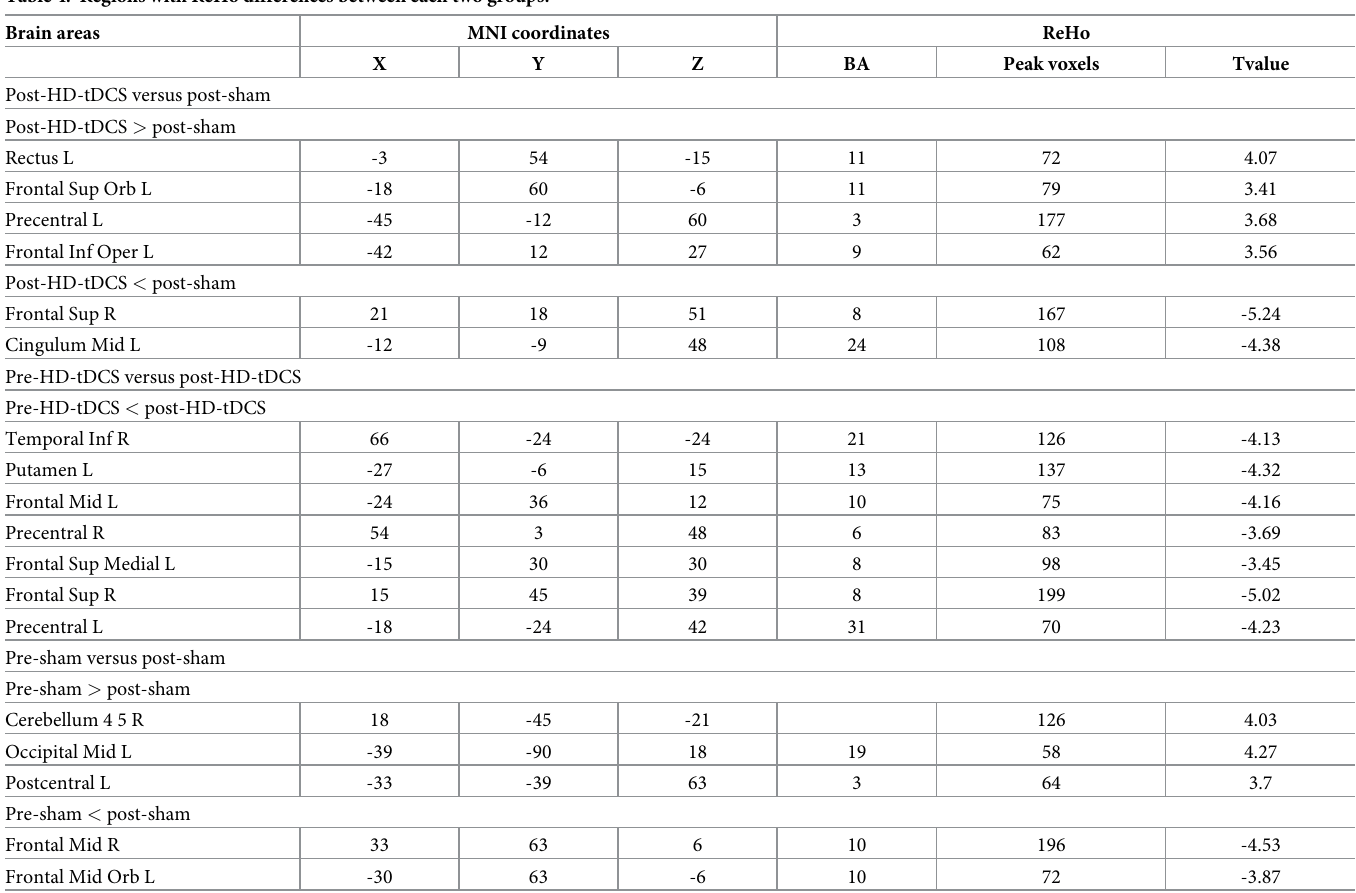
Table 4. Regions with ReHo differences between each two